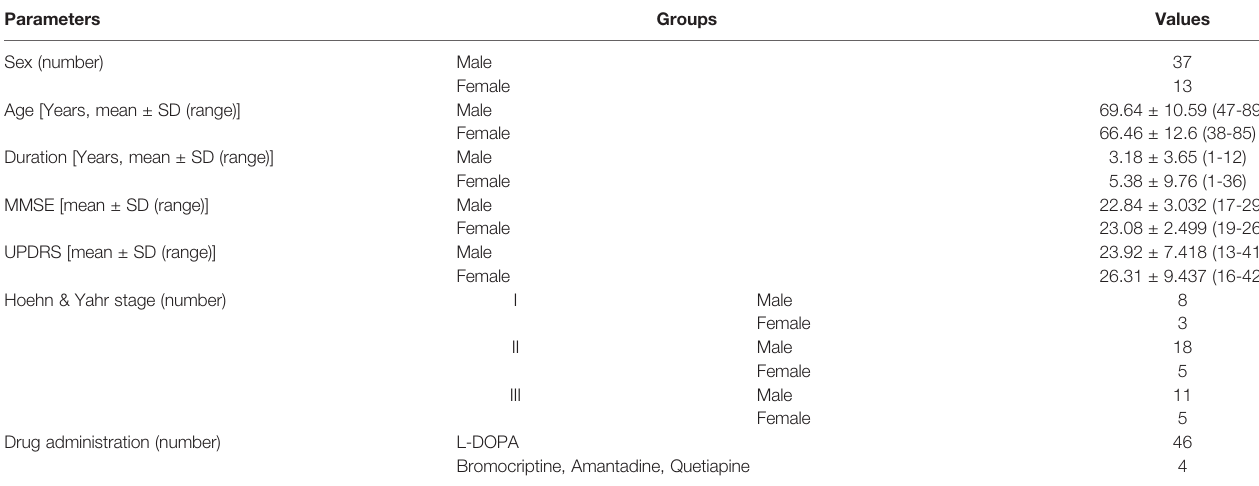
TABLE 2 | General data of cases.